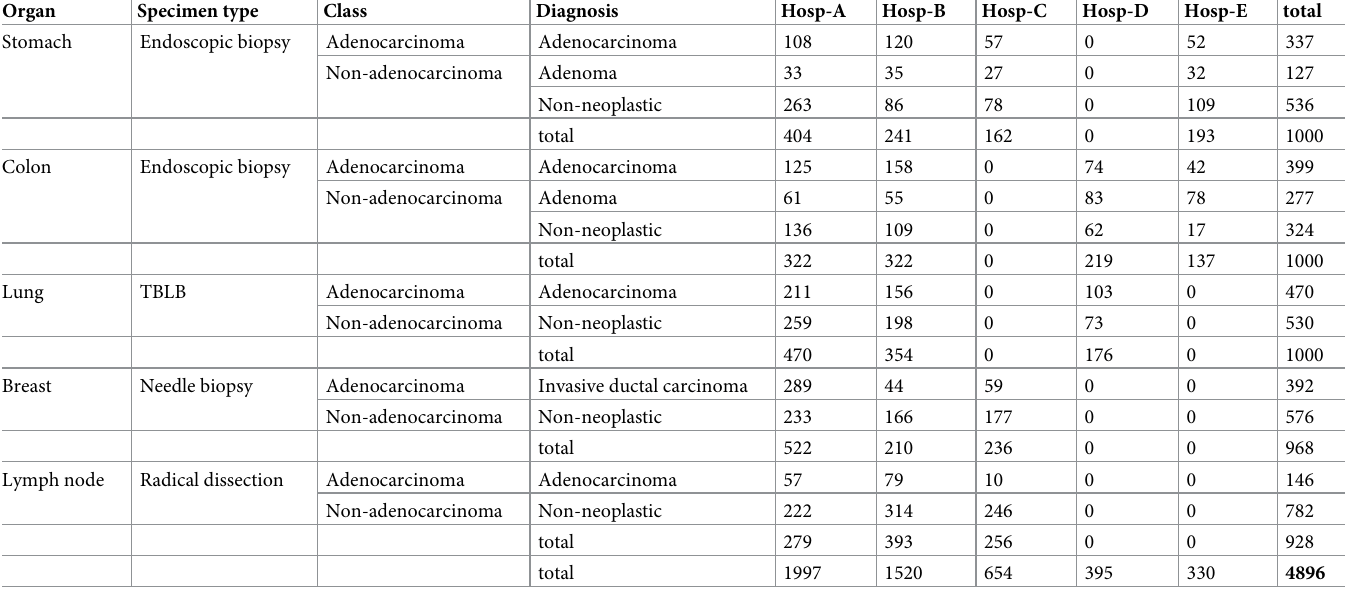
Table 3. Distribution of cases in the test sets obtained from hospitals (A-E). Organ